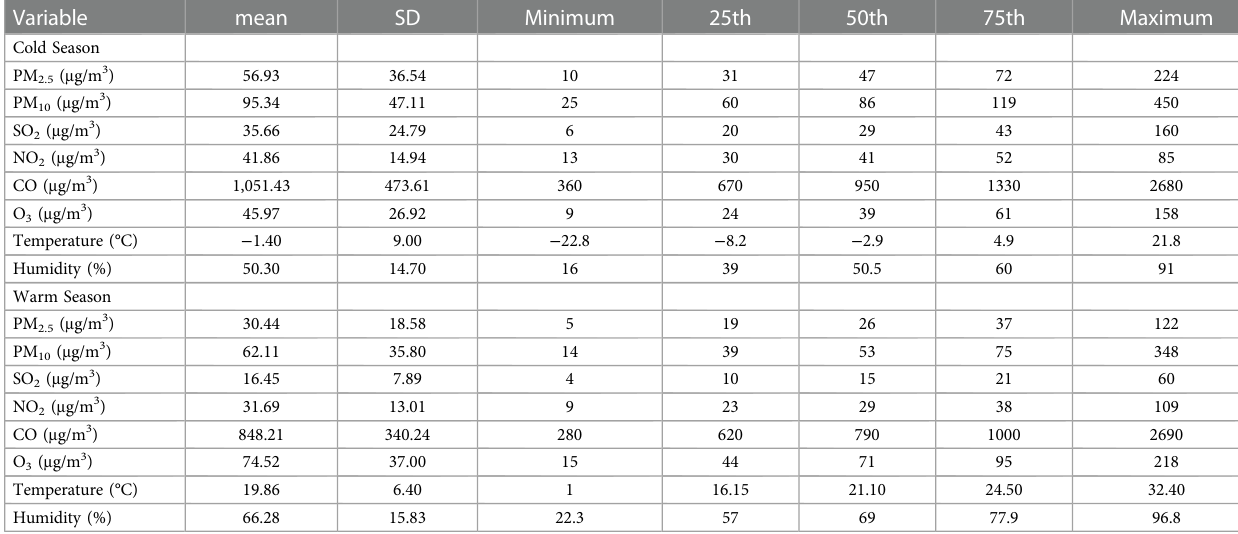
TABLE 3 Descriptive statistics of statistics of daily environment data in Shenyang from 2017 to 2019 after seasonal strati fi cation.